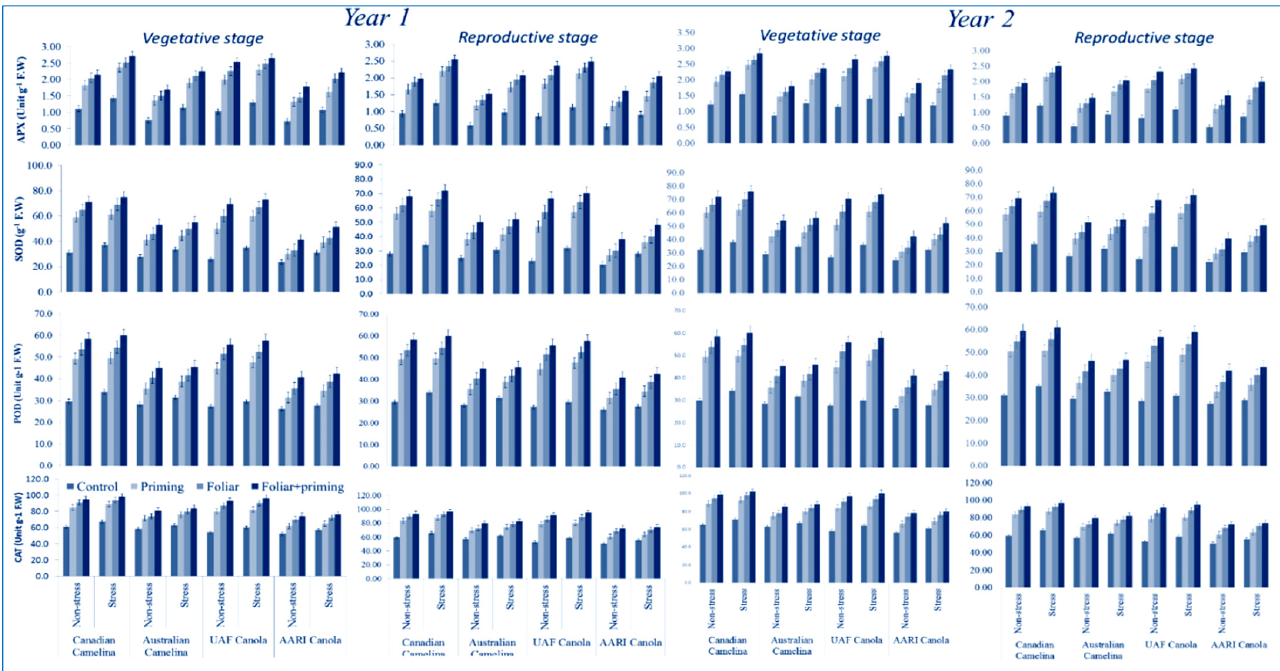
Figure 3. Impact of Se application (seed priming and foliar) on antioxidant activities at both stages (vegetative and reproductive) of oilseed crops (camelina and canola) subjected to water deficit in the year 2016–2017 (mean values ± S.E).